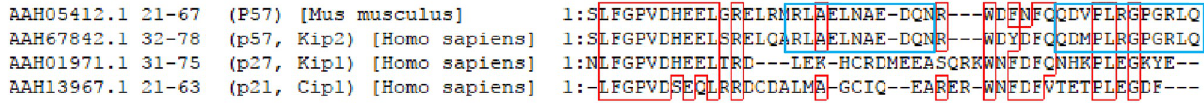
Fig 5. CDKI domains of Cip/Kip family molecules. Characteristic CDKI domains were compared among mouse ( Mus musculus ) p57 Kip2 , human ( Homo sapiens ) p57 Kip2 , p27 Kip1 and p21 Cip1 . Identical amino acid residues in 3 of 4 peptides are enclosed with a red line. A blue line surrounds p57 Kip2 - specific peptides, which were shared by mouse and human